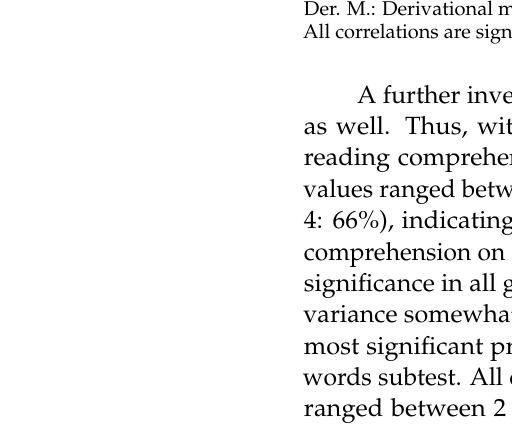
Table 7. Correlations among different aspects of morphological awareness and reading compre ‐ hension.